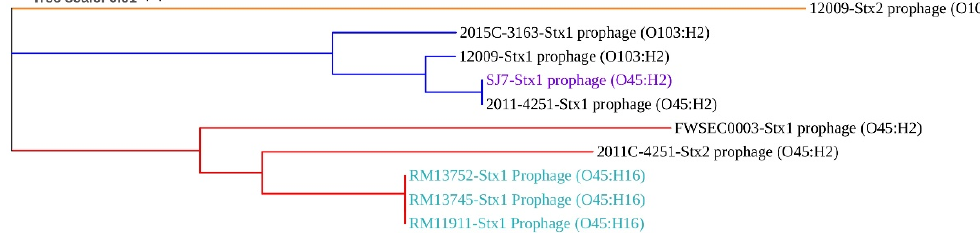
Figure 4. Maximum likelihood phylogenetic analysis based on the MAFFT algorithm of the Stx prophages from the genomes of six STEC O45 strains and two STEC O103:H2 strains. The phylogenetic tree indicates three distinct clusters among the Stx prophages, in orange for cluster 1, navy for cluster 2, and red for cluster 3. Stx prophages highlighted in purple and light blue indicates they were obtained from the bacterial strains sequenced in this study. All Stx prophage sequences in the bacterial chromosome were predicted using the PHASTER web server.